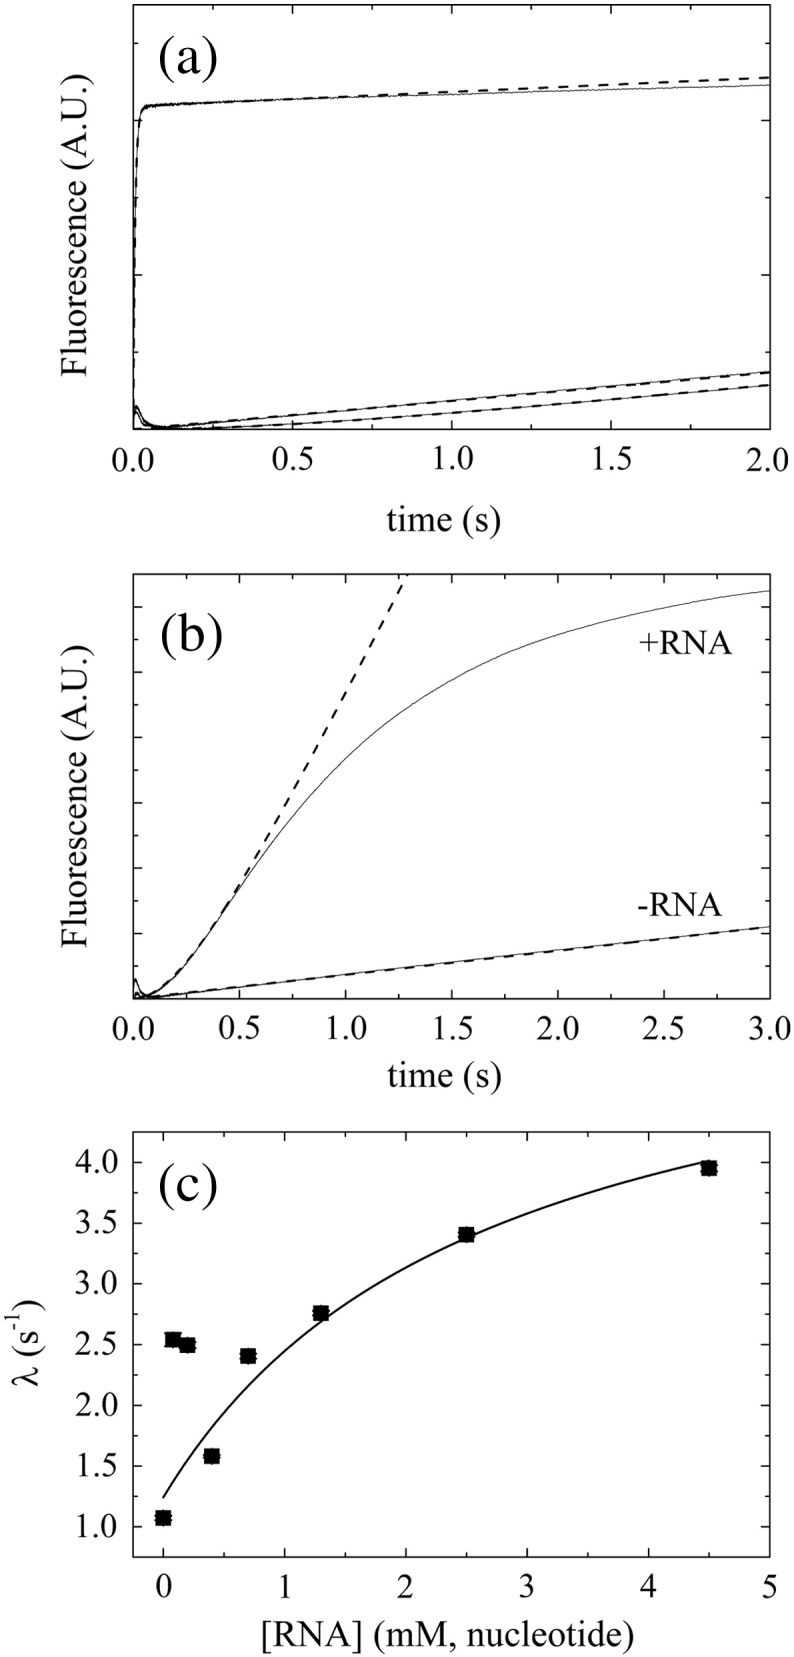
Transient RNA-stimulated Pi release during Dbp5 ATPase cycling. (a) Time courses of fluorescence change after mixing 5 μM Dbp5 with 4 mM ATP and aging for (lower to upper) 0.05, 6, or 25 s prior to rapidly mixing with 5 μM PiBiP. Broken lines are best fits to (lower to upper) Eq. (14), linear equation, or bimolecular binding plus a linear phase, respectively. (b) Time courses of fluorescence change after mixing 5 μM Dbp5 with 4 mM ATP, aging for 6 s, and then rapidly mixing with 0 or 10 mM RNA in the presence of 5 μM PiBiP. Fits to Eq. (16) are shown as broken lines through the data. (c) [RNA] dependence of the observed Pi release lag phase rate constant (λ) where pre-equilibrated Dbp5 and RNA are rapidly mixed with ATP and PiBiP. Continuous line through the data points represents best fit to a rectangular hyperbola [Eq. (15)], yielding a maximum observed rate constant of 5.5 ± 2 s− 1 upon extrapolation of the fit to saturating RNA. The [RNA] at half maximal is ~ 3 mM under these nonsaturating ATP concentrations.